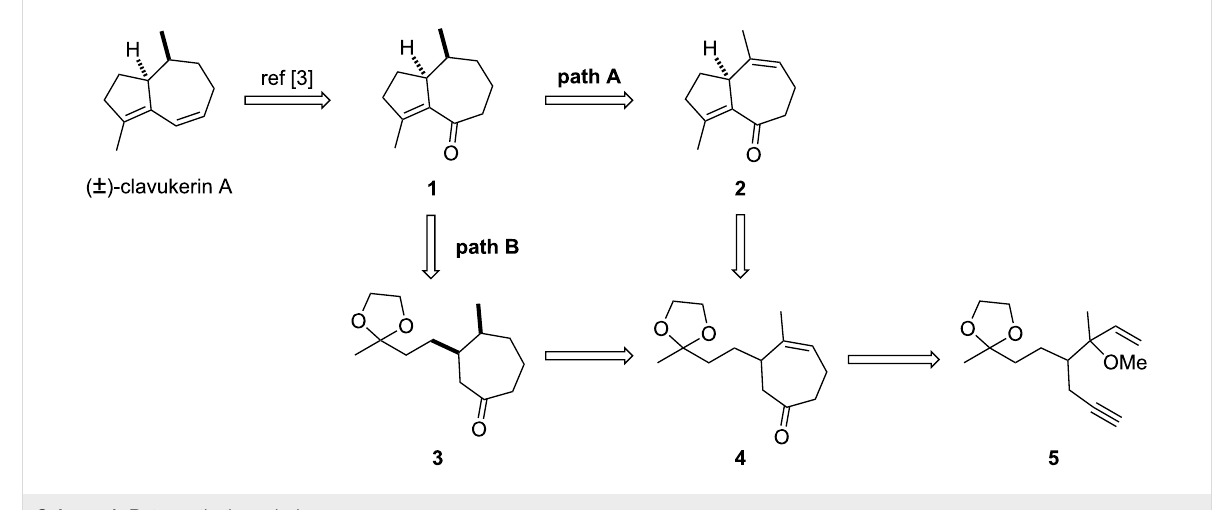
inseparable 3:1 mixture of diastereomers. The